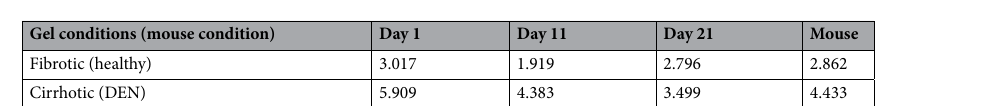
Table 1. Liver stiffness (kPa) determined via parallel plate rheology in 3D hydrogels and liver samples derived from a DEN-induced model for HCC.